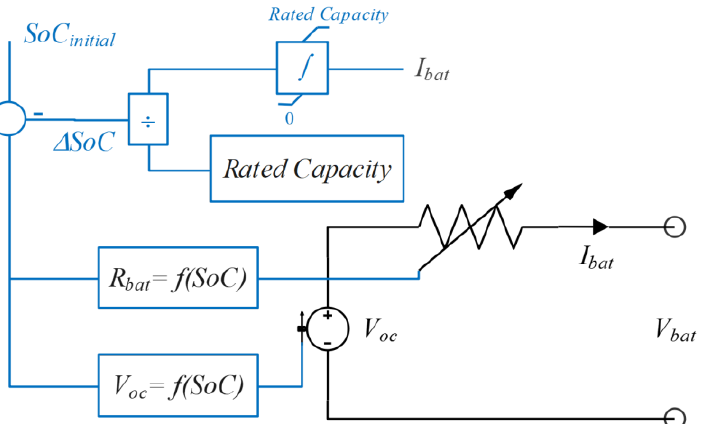
Figure 6. Implemented model of the battery pack.